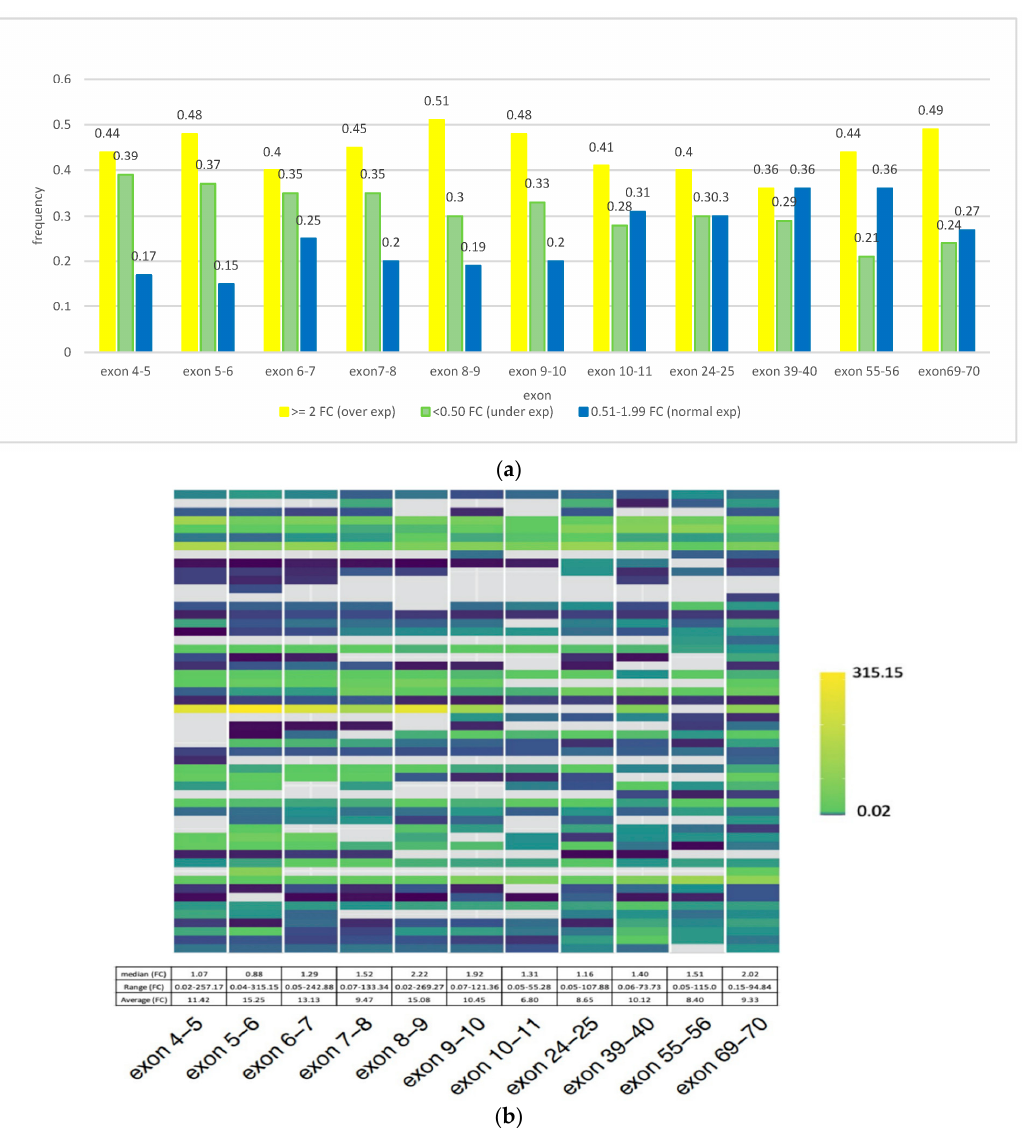
Figure 2. ( a ) Distribution of mRNA expression of CSMD1 in ESCC. The yellow bar indicates the frequency of cases with overexpression (fold change (FC) ≥ 2.00); green bar indicates frequency of cases with underexpression (FC ≤ 0.50); blue bar indicates frequency of cases with expression in the normal range (FC 0.51–1.99). ( b ) Individual ESCC case mRNA expression levels for the 11 exon boundaries studied, shown as fold change (FC) (top, heatmap) and as median, range, and mean across the 54 cases examined in each of the 11 exons tested (bottom). Each row in the heatmap represents an individual case, and each column represents mRNA expression levels in a single exon boundary tested. FC ranges from lowest (0.02, blue) to highest (315.15, yellow). Gray denotes probe with no data